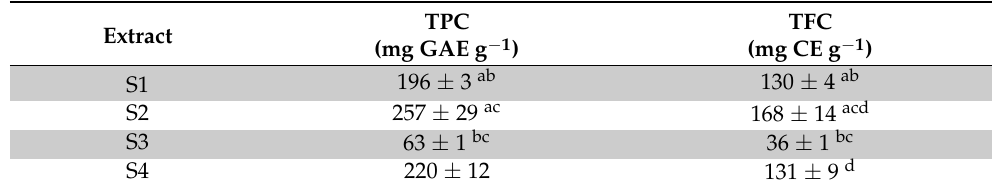
Table 2. Total phenolic content (TPC) and total flavonoid content (TFC) of E. arvense L. extracts with four different solvents. The results are expressed as mean ± SD from 3 independent measurements in each case. Values in each column that share the same letter differ from each other (Mann–Whitney u-test, p < 0.05). TPC Extract